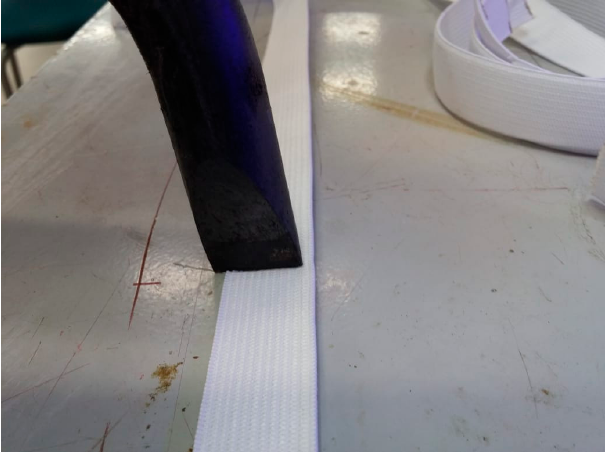
Figure 5. Cutting of elastic band by means of hot knife—soldering iron.